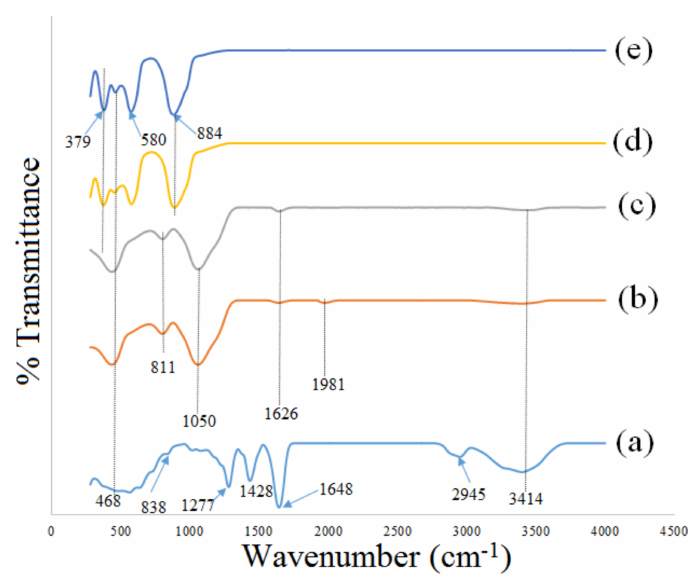
Figure 3. FT–IR spectra of ( a ) uncalcined sample and willemite NPs calcined at 900 ◦ C over a range of